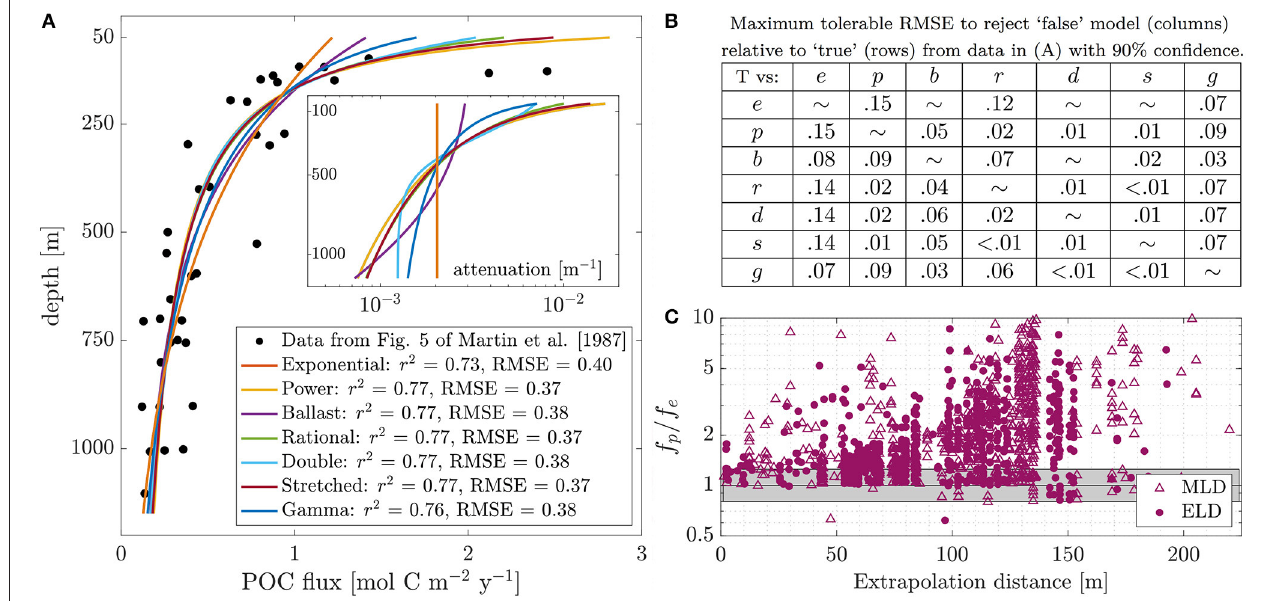
FIGURE 1 | (A) Seven models from the text fit to mesopelagic data from Figure 5 of Martin et al. (1987; their Open Ocean Composite’) and extended upwards to 50 m depth. Goodness-of-fits are very similar, but the power-law model overestimates particulate organic carbon (POC) flux at 50 m by 132% relative to the exponential model. Inset shows attenuation ( 1 f df dz ) differences are even more pronounced. Attenuation for the exponential model coincides with most others around ∼ 400 m. (B) Maximum tolerable root-mean-square error (RMSE) to distinguish models based on data from (A) with 90% confidence, estimated using a bootstrap method (see text and Supplementary Material iii for details). Row corresponds to “true” model (from which data are assumed to be generated) and column corresponds to “false” model (to be rejected). RMSEs are small relative to those in (A), indicating differences in goodness-of-fits between the models are not statistically significant. (C) Ratio of power-law-model- and exponential-model-estimated POC flux at euphotic layer and mixed layer depths from the profiles in the data compilation as a function of extrapolation distance. Gray shading shows nominal 25% measurement uncertainty. Note the y -axis is logarithmic. The power-law model systematically and substantially overestimates relative to the exponential model (as well as the other models Supplementary Material ii.c ). For 29 profiles, f p (MLD) / f e (MLD) > 10 (not